Question: What direction does the quantity move in — increasing or decreasing?
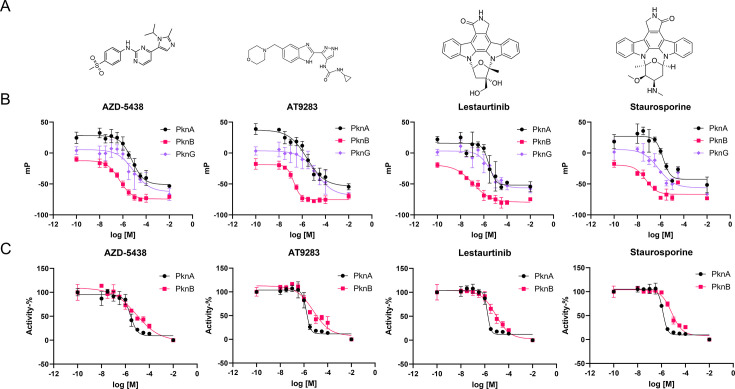
Answer: increasing